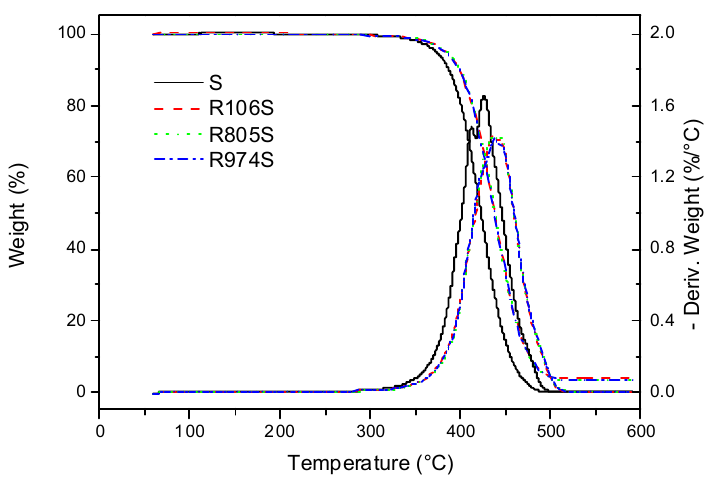
Figure 2. TGA thermograms of base oil and HFS suspensions at a heating rate of 10 °C·min − 1 .